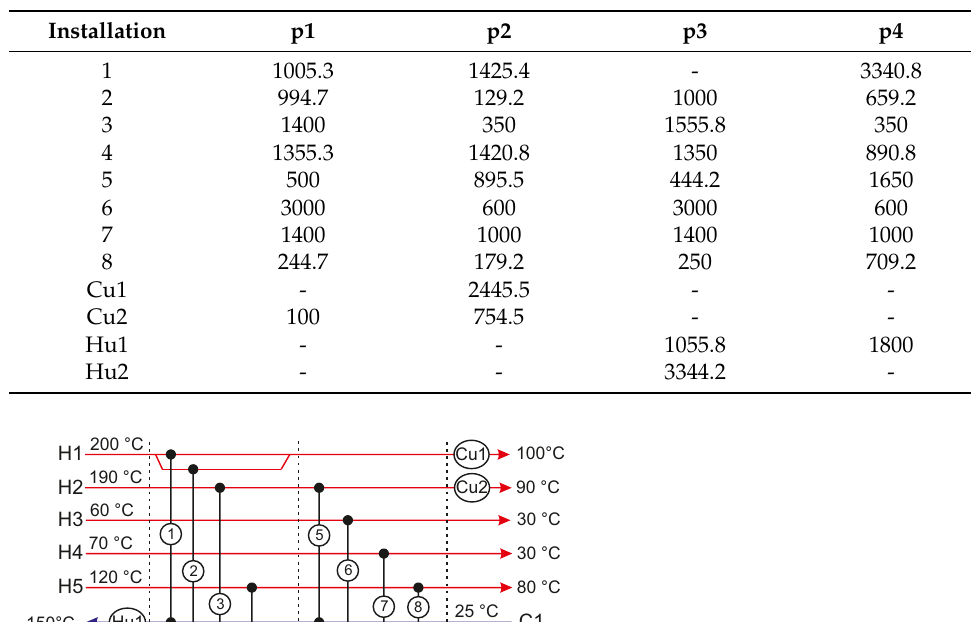
Table 5. Heat Flows without HP and ST case 1 (kW).